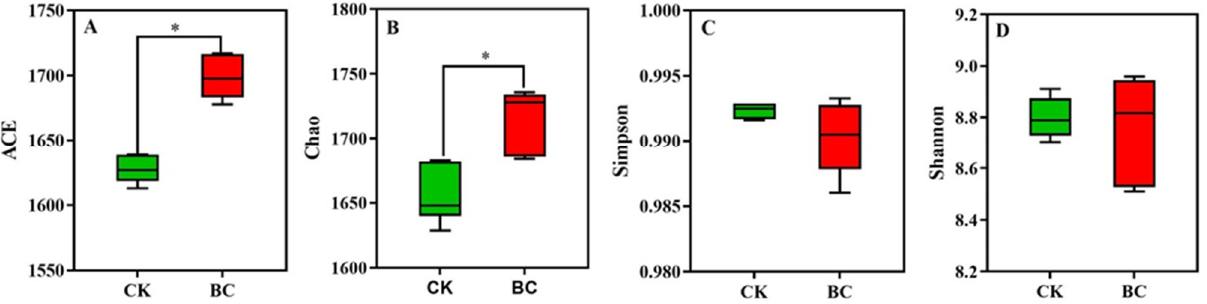
Figure 3. Effect of biochar on richness and diversity index (( A ), ACE; ( B ), Chao; ( C ), Simpson; and ( D ), Shannon) of soil bacterial communities in a dry direct-seeded rice paddy. CK, conventional fertilizer; BC, biochar with conventional fertilizer. The error line represents the standard error ( n = 6). * Indicates a significant difference between CK and BC treatments ( p < 0.05).